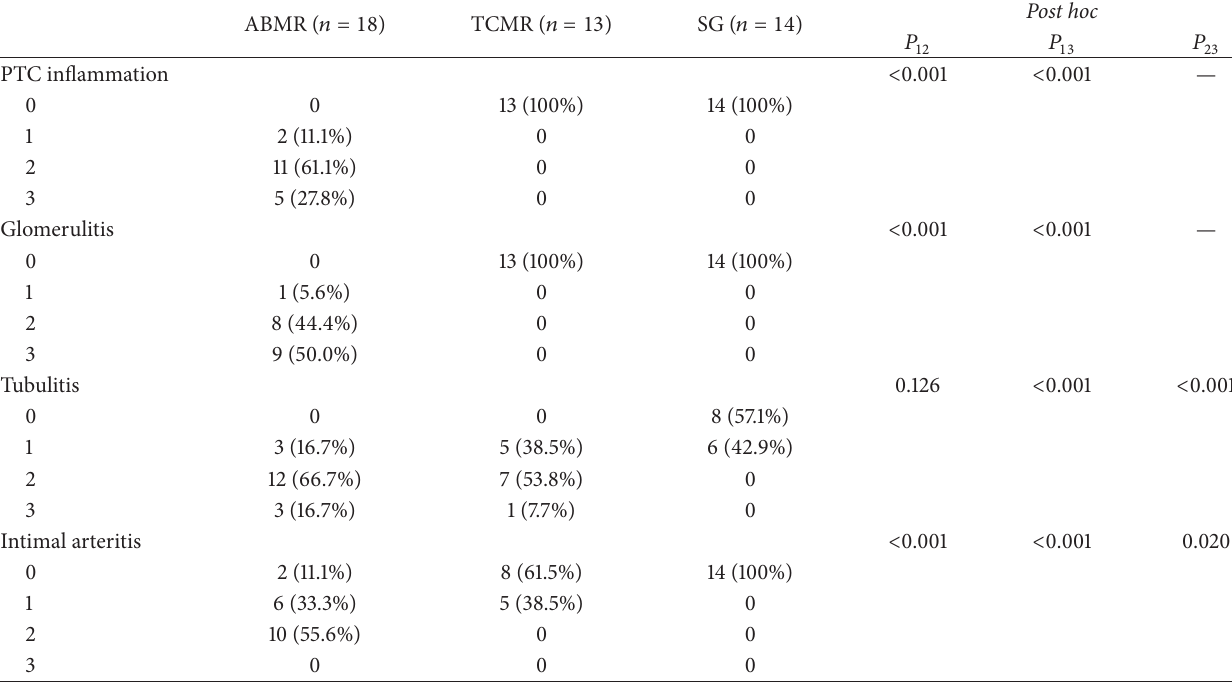
Table 3: BANFF scoring in different